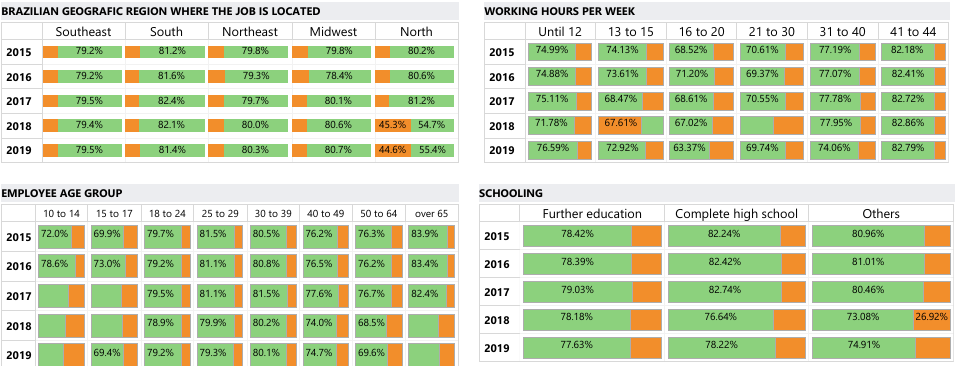
Figure 1. Analysis of the labor market in Information Technology using data from the Annual List of Social Information (RAIS) for the years 2015 to